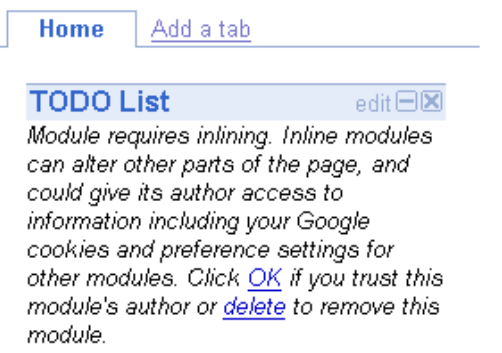
Figure 1. Google Cross-communication Warning